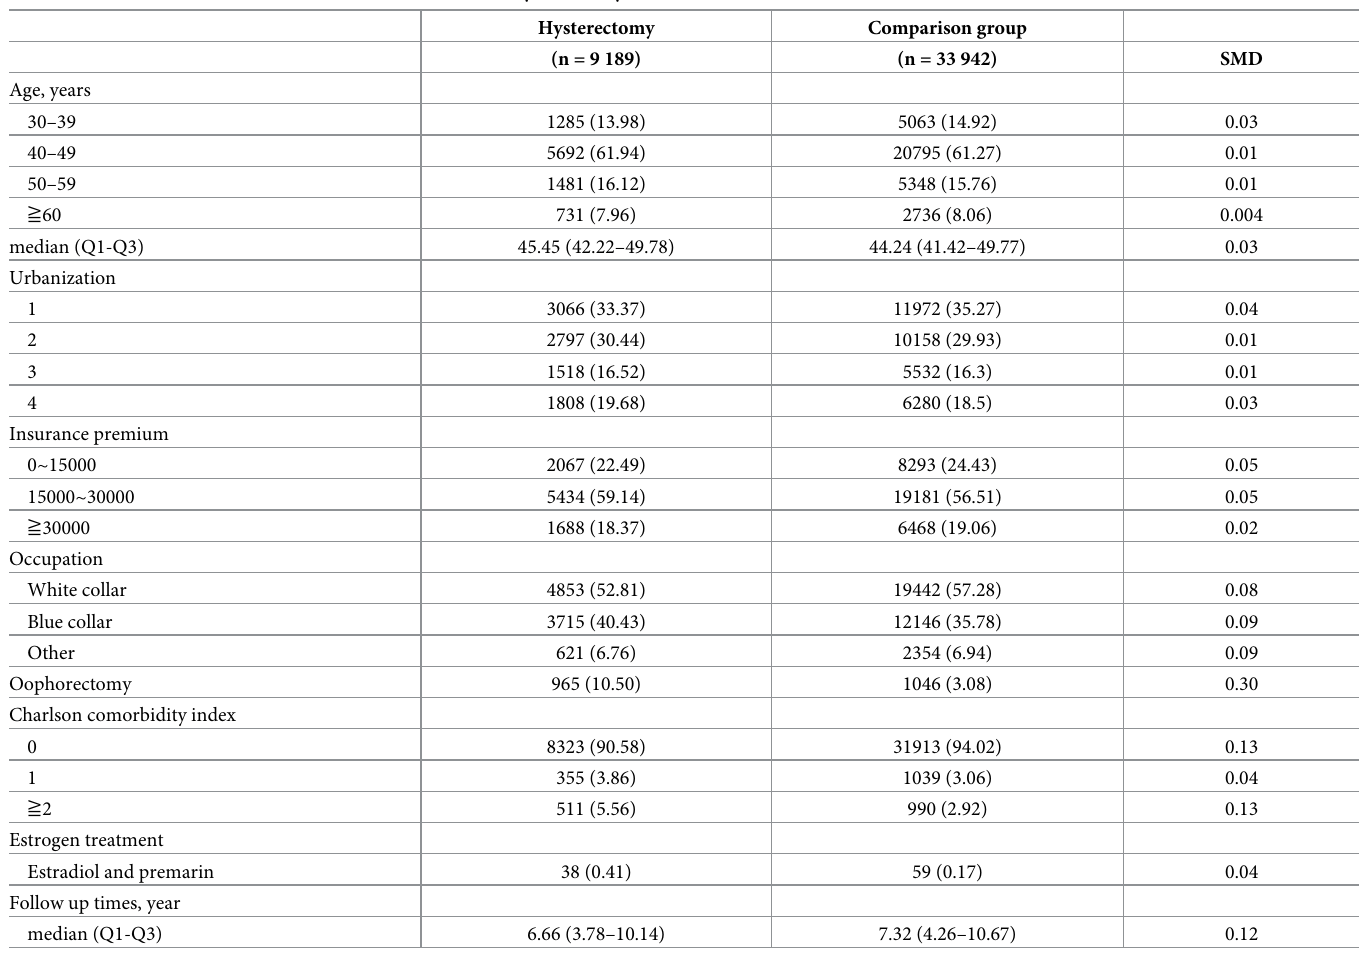
Table 1. Baseline characteristics in women with and without